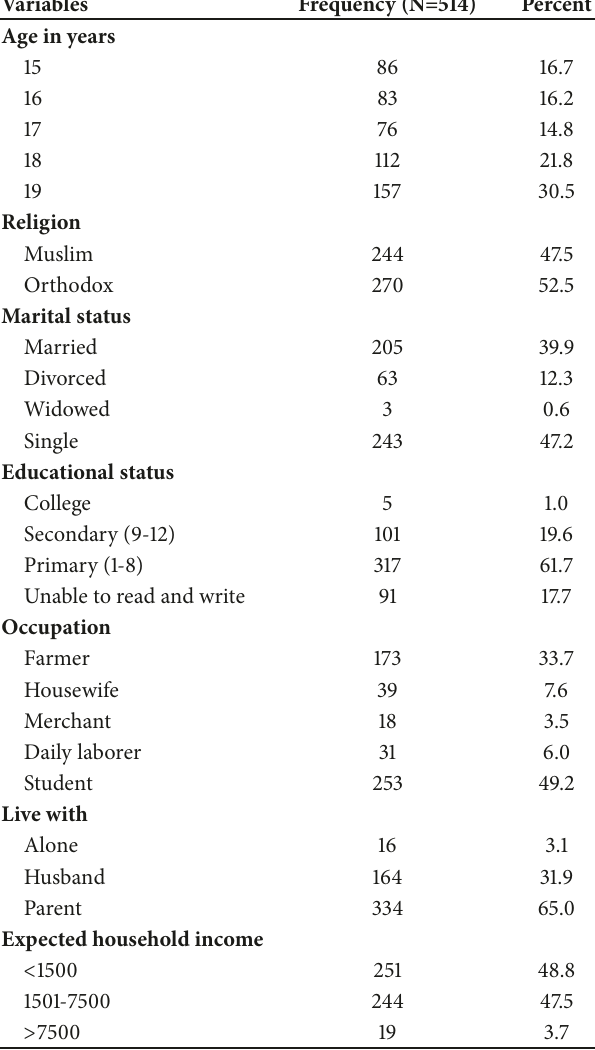
Table 1: Sociodemographic characteristics of teenagers in Wogedi, northeast Ethiopia,